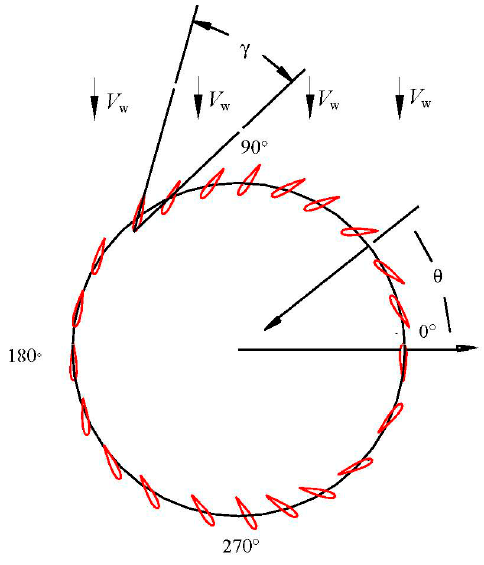
Figure 3. Illustration of cyclical variable pitch.